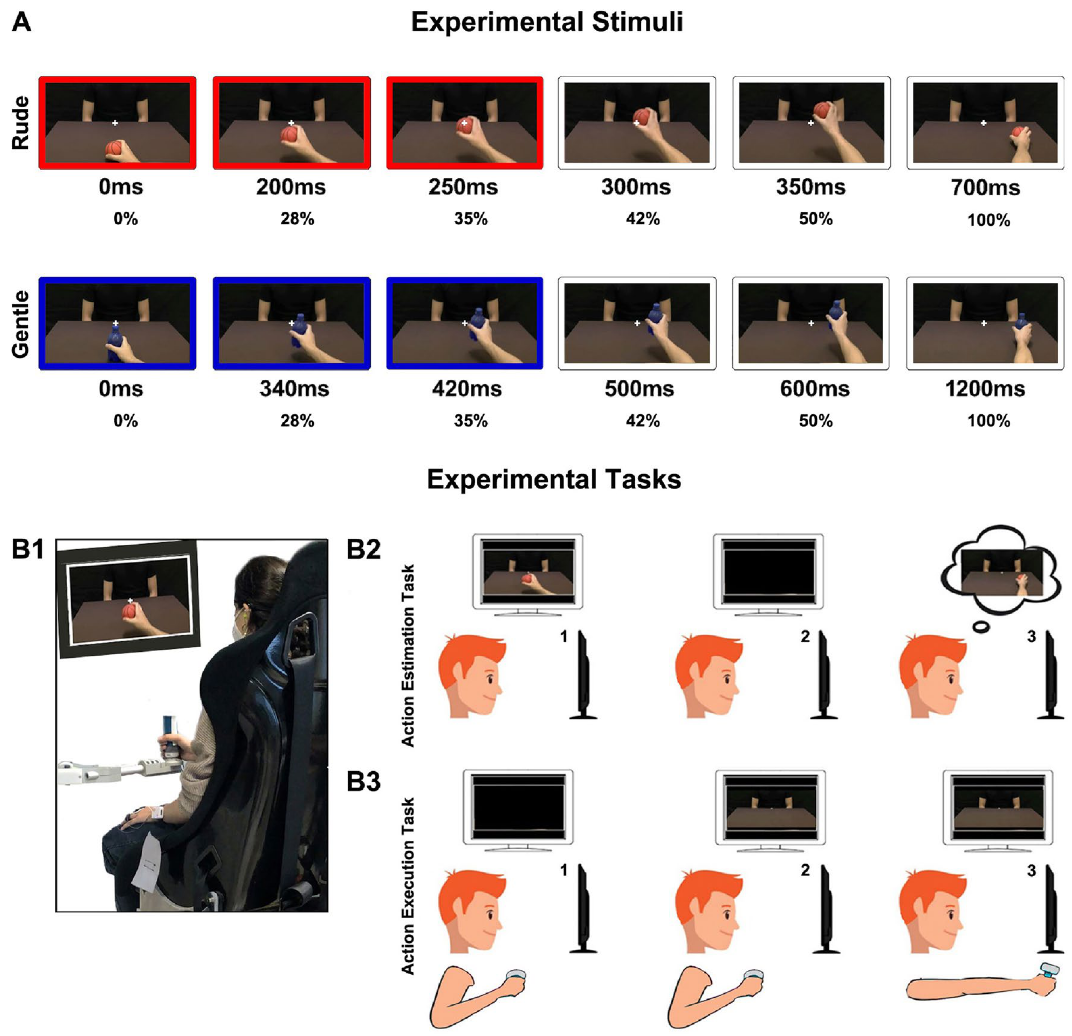
Figure 1. Visual stimuli ( A ): the total duration was respectively 700 ms for rude actions and 1200 ms for gentle actions. The stimuli consisted in presenting the 35% of the entire duration: 250 ms for rude actions (red color) and 420 ms for gentle actions (blue color). Example of a participant during the experiment ( B1 ). Action Estimation Task ( B2 ): (1) participants observed the initial part of a passing action, (2) the action was obscured, (3) they continued the action mentally estimating the time of its conclusion. Action Execution Task ( B3 ): (1) starting position, (2) a static image of an actor appeared, (3) participants performed the passage moving the